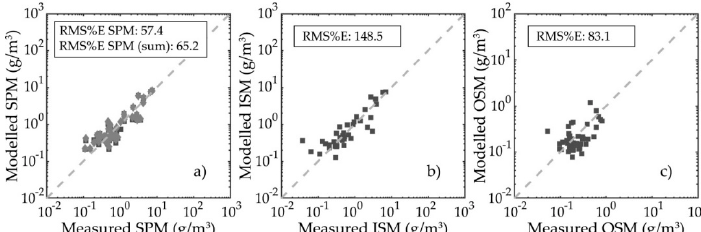
Figure 4. Comparison of modelled vs. measured ( a ) SPM, ( b ) ISM, and ( c ) OSM values for a simple spherical volume model. SPM values derived from the total PSD are represented as dark grey squares, while SPM values calculated as the sum of ISM and OSM are represented as light grey diamonds. The dashed grey lines indicate the 1:1 relationship.